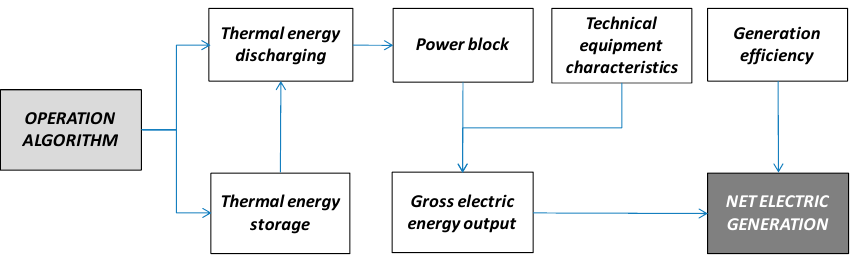
Figure 7. Functional unit for power block and net electric energy output models.